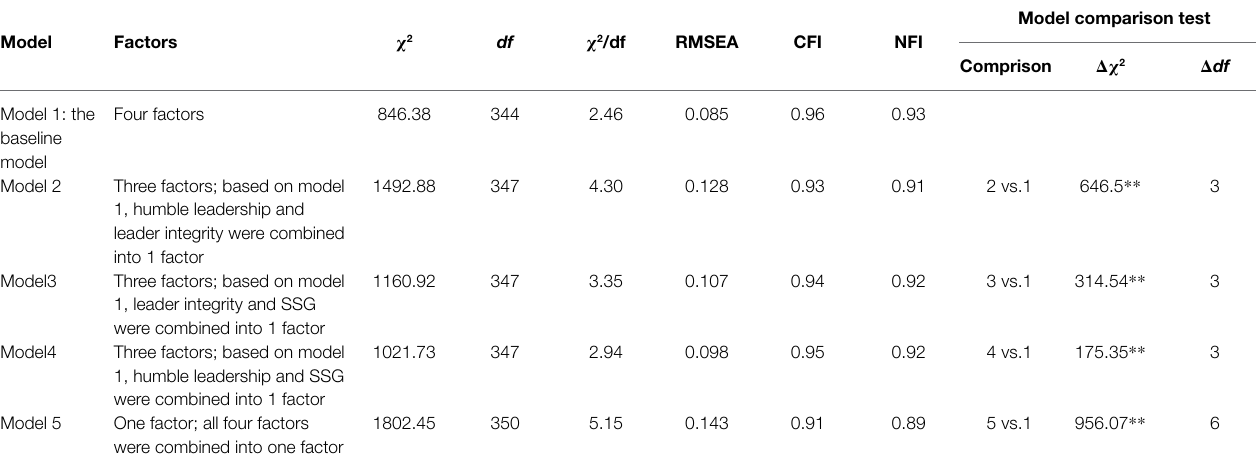
TABLE 1 | Results of the confirmatory factor